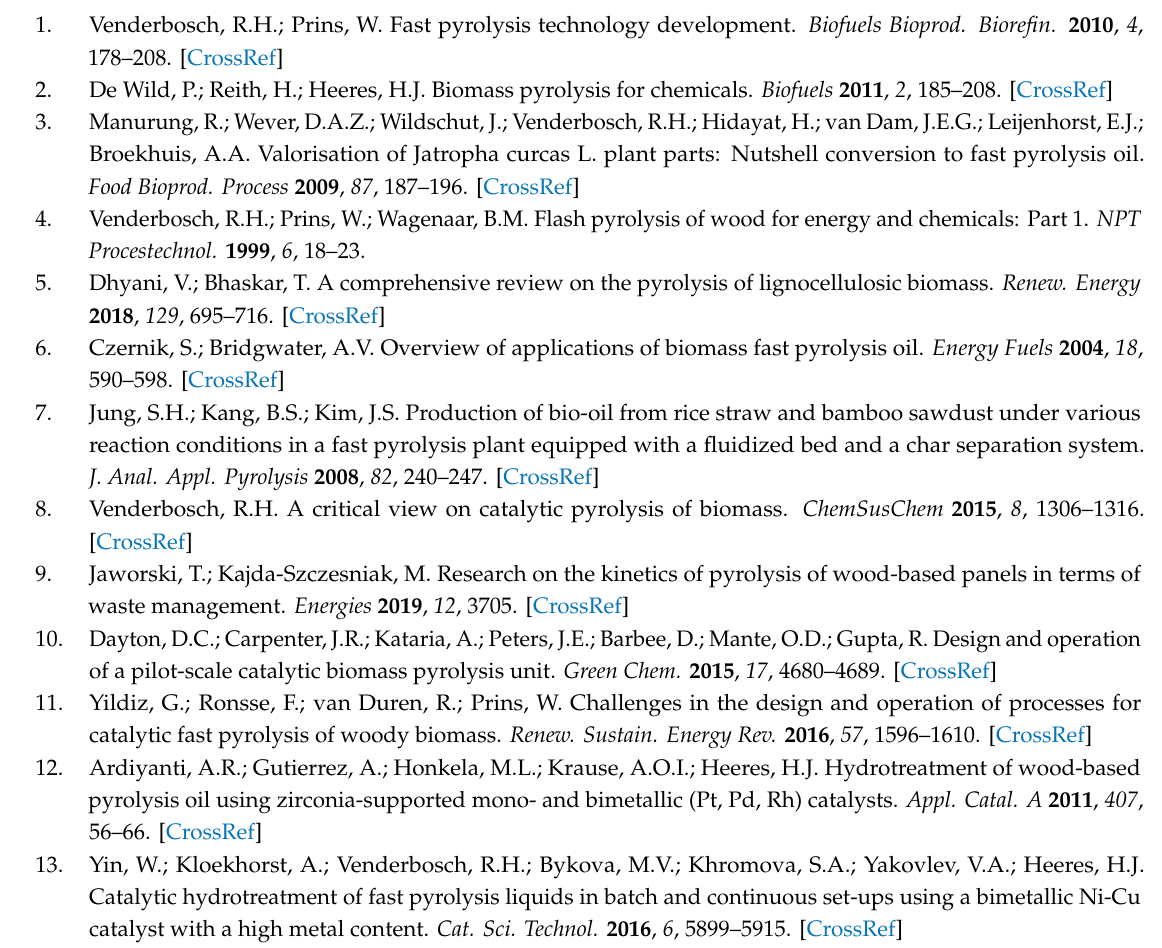
Figure S1: Schematic diagram of the fluidized bed reactor set-up used for the pyrolysis of pigeon pea wood, Figure S2: TGA profile of the pigeon pea wood sample used for pyrolysis (N 2 atmosphere), Table S1: Solid, liquid (bio-oil) and gas yields from pigeon pea wood pyrolysis performed at various conditions in a semi-continuous reactor